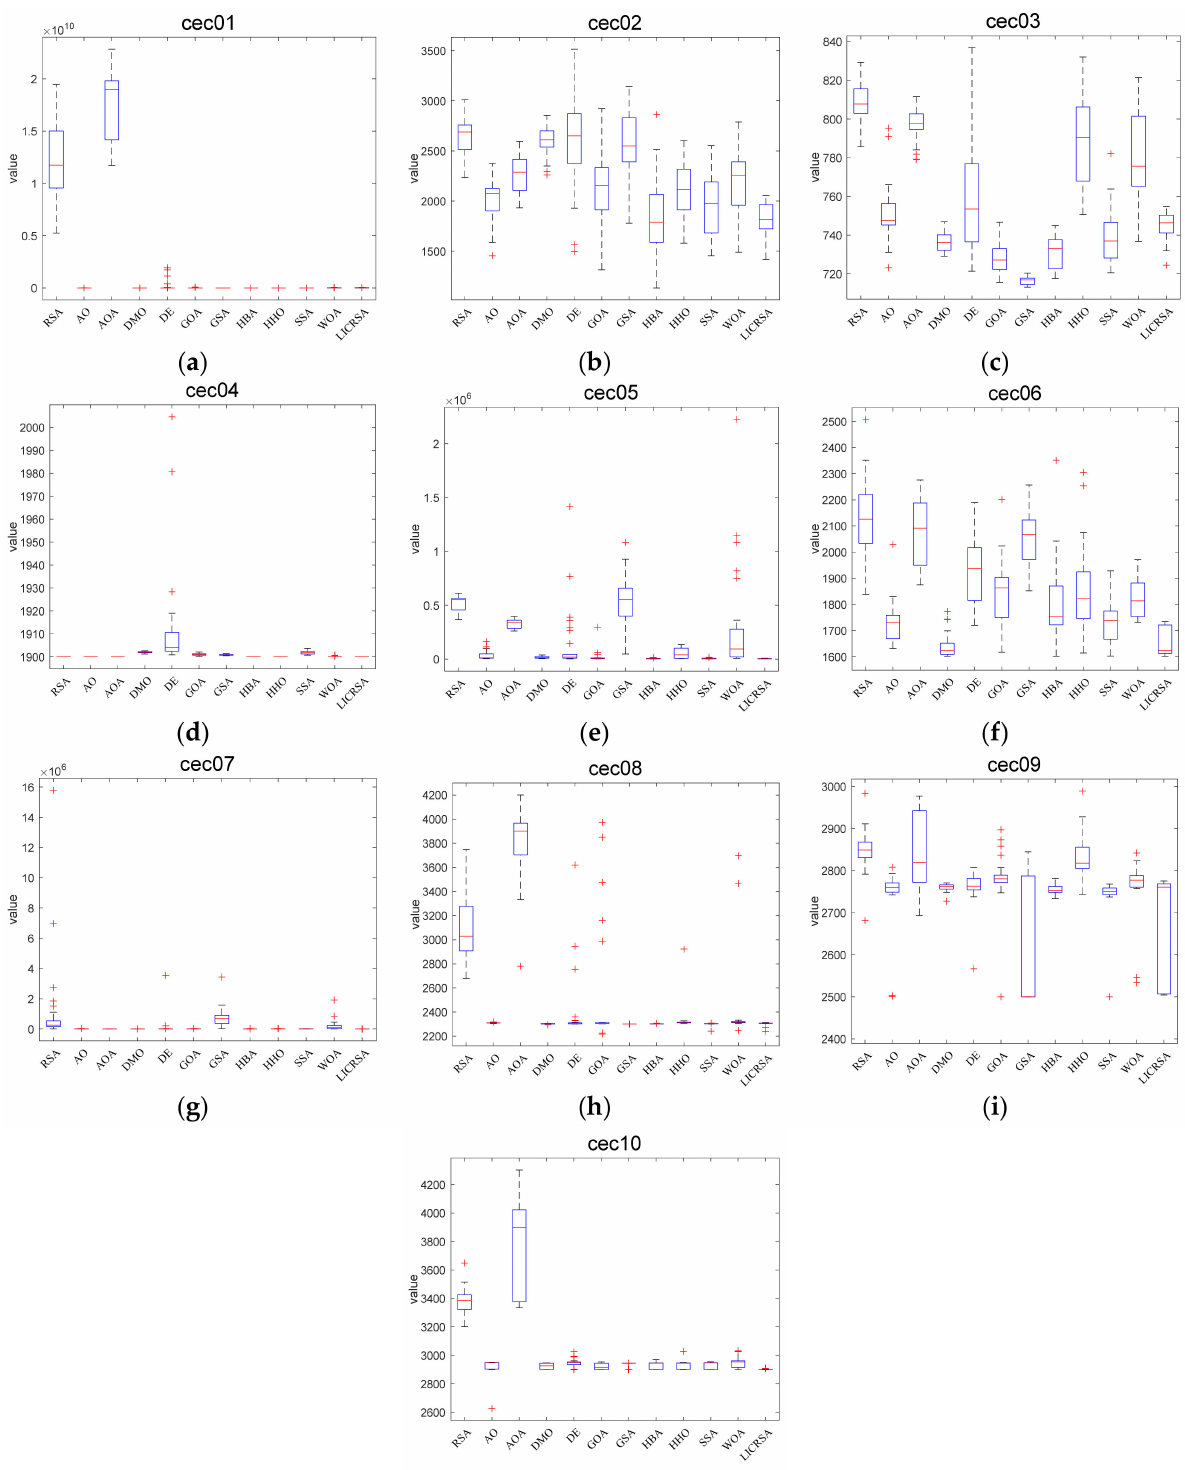
Figure 10. Box plot of the LICRSA and other MH algorithms on CEC2020: ( a ) cec01; ( b ) cec02; ( c ) cec03; ( d ) cec04; ( e ) cec05; ( f ) cec06; ( g ) cec07; ( h ) cec08; ( i ) cec09; ( j )